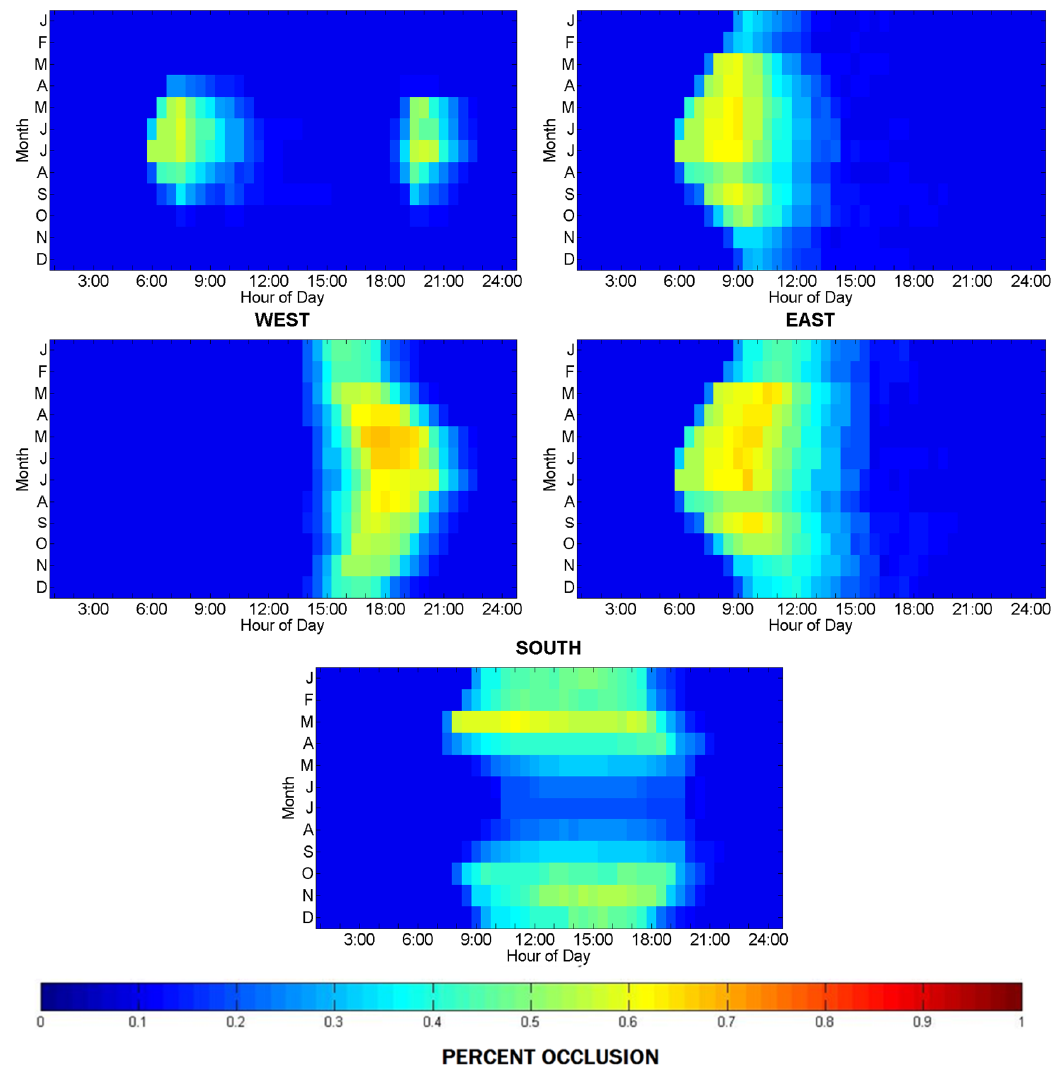
Figure 13. Hourly average percent occlusion for second floor (Blindswitch